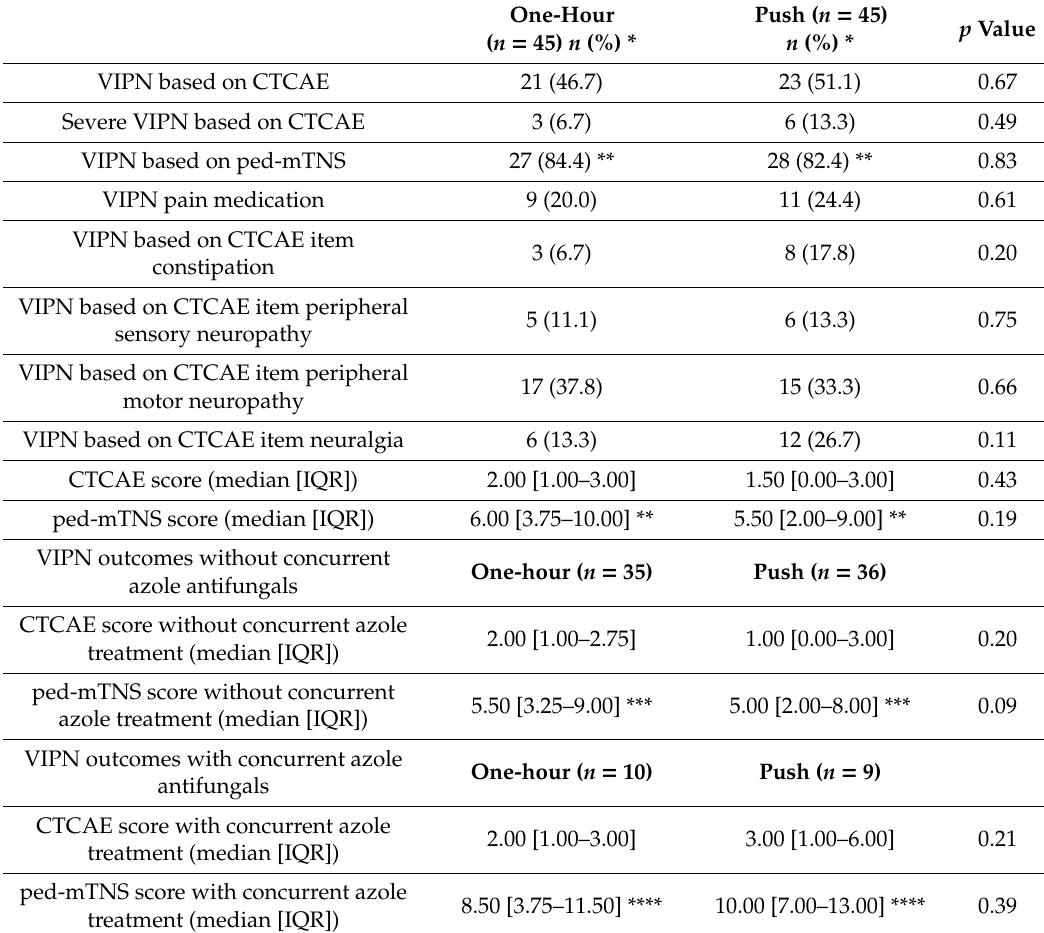
Table2. Incidenceofvincristineinducedperipheralneuropathyofparticipantsinbothrandomizationgroups.